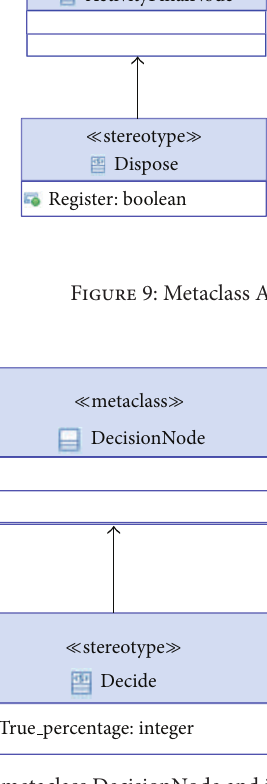
The proposed profile presents advantages at two